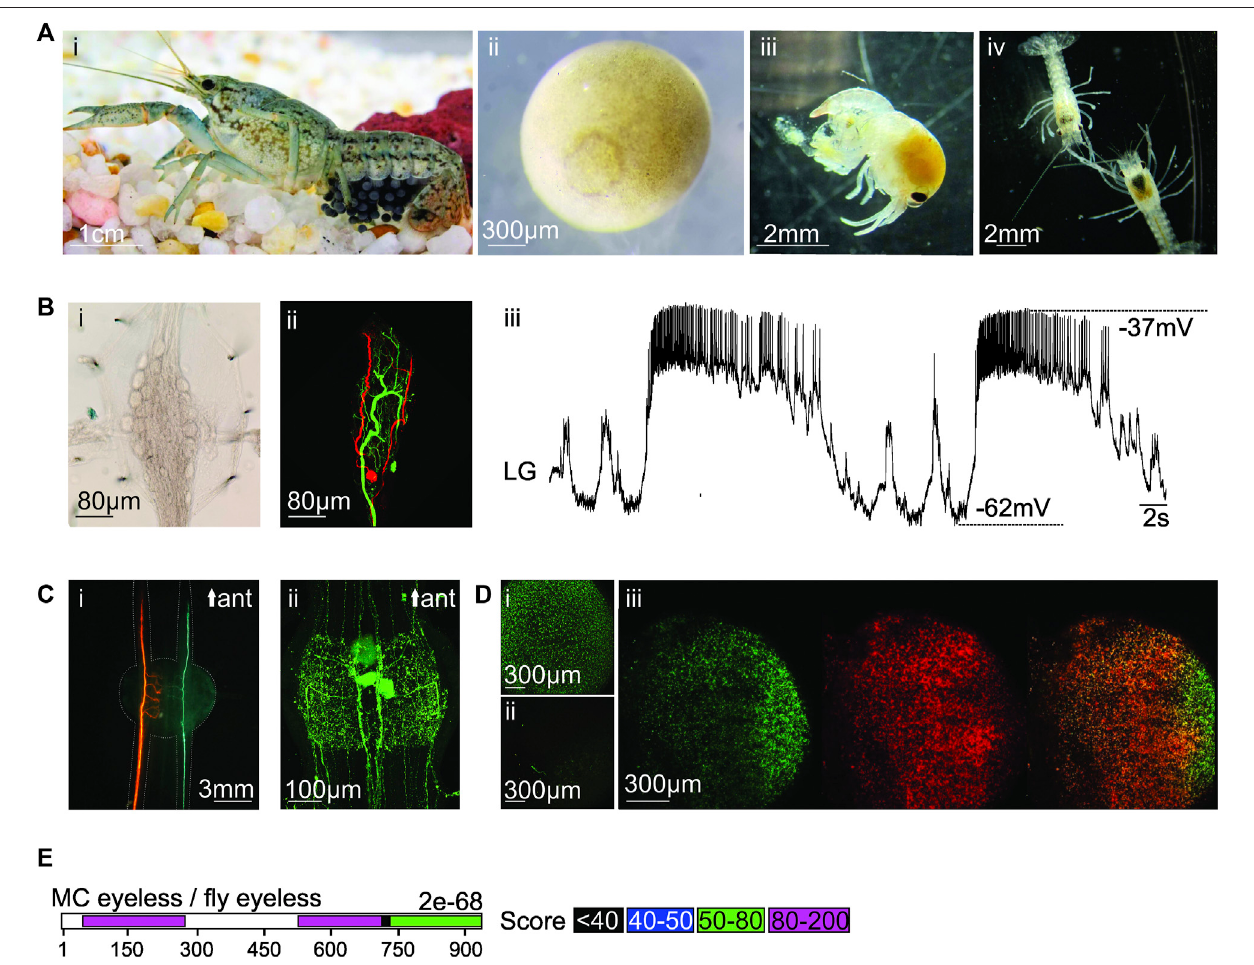
FIGURE1|(A) (i)Photoofpregnantmarbledcray fi sh.Credits:CarolaStädele.(ii)Magni fi cationofstage2oocyte(10 – 15%development)withcircularblastophore. (iii) Freshly hatched juvenile (stage 1). (iv) Two translucent stage 2 juveniles. Digestive tract and hepatopancreas are clearly visible. (B) (i) Bright fi eld image of adult stomatogastric ganglion with neuronal somata of the pyloric and gastric mill central pattern generators. (ii) Confocal image of two stained stomatogastric neurons. Somata,axonsand neuropil arevisible.(iii) Intracellular recording oflateral gastric (LG) neuron in thestomatogastric ganglion. Signal tonoise ratioand waveform of themembrane potentialoscillationsaresimilartoothercrustaceans(Steinetal.,2022). (C) (i)Stainingofthetwobilaterallysymmetriclateralgiantneuronsinthemarbled cray fi sh ventral nerve cord. (ii) Immunohistochemical staining against Serotonin in a marbled cray fi sh ventral nerve cord ganglion. (D) (i) Oocyte containing GFP after ReMOT treatment. (ii) A control oocyte shows no GFP staining. (iii) Overlay of GFP (left) and anti-GFP immunohistochemistry (middle) in oocyte. Right: Yellow delineates overlap in GFP and anti-GFP fl uorescence signals. (E) Sequence alignment between putative MC eyeless and fl y eyeless transcripts. Colored bars: signi fi cant alignment with scores between the two sequences. Overall e-value is provided.